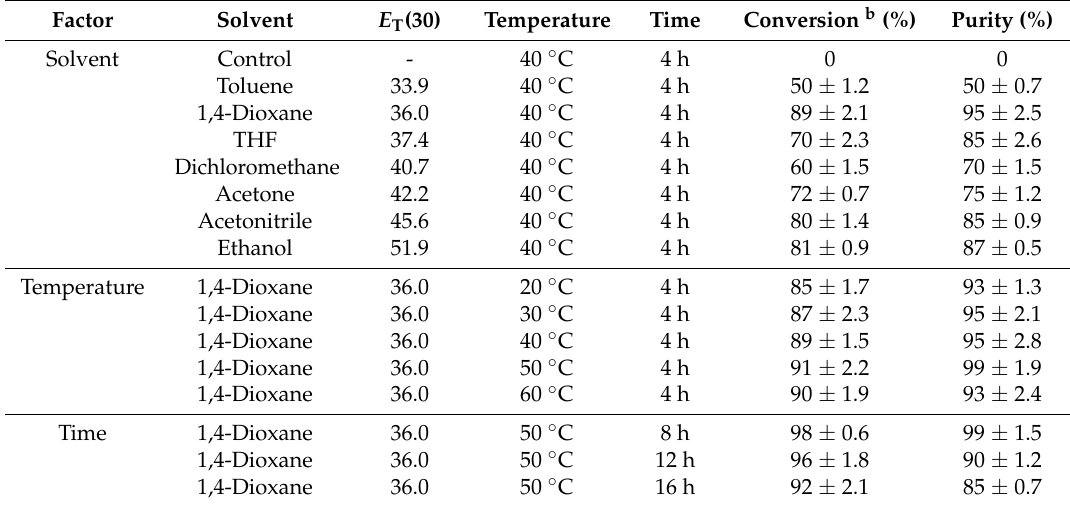
Table 3. Single experiments in the chloramphenicol ester synthesis reaction.